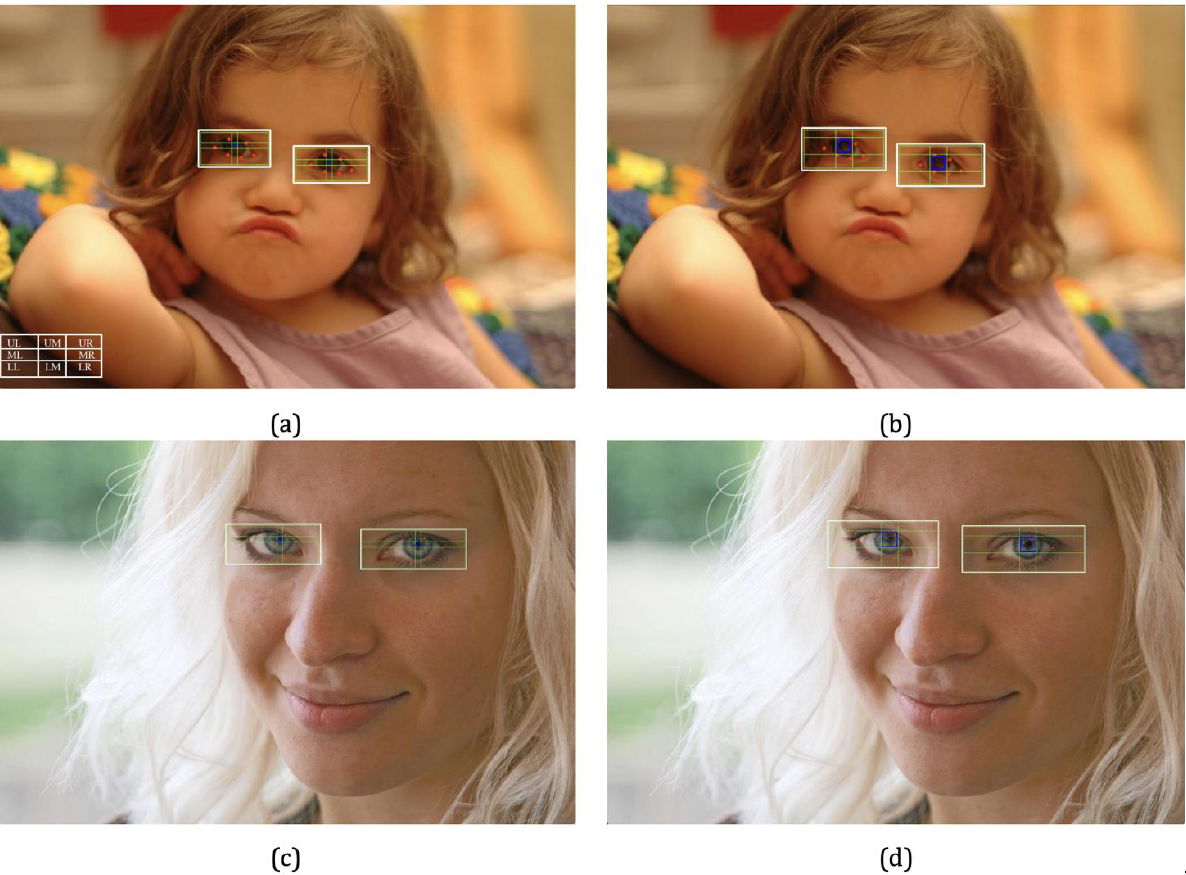
Figure 1. Sample images along with the definitions of a set of non-overlapping bounding boxes with two sizes of P: α = 1 in (a) and (c) and α = 3 in (b) and (d), and two sizes of K: original size in (a) and (c) and the β of 1.125 (b) and (d). These images are part of the 300W dataset, which is freely available for non-commercial